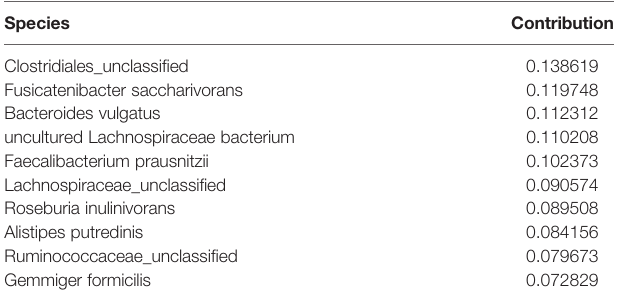
TABLE 2 | List of the top 10 species for contributions that were used in the random forest model.